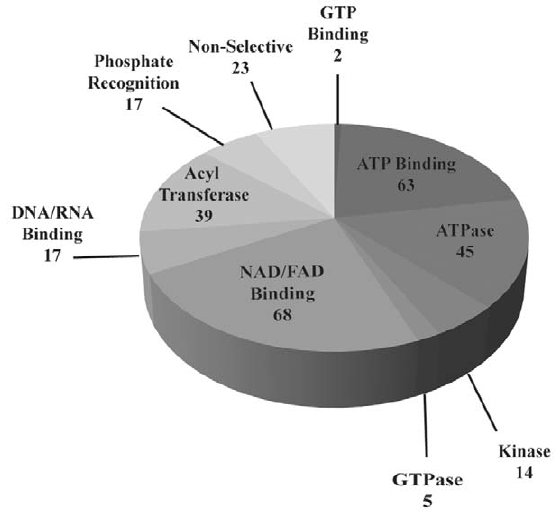
Figure 3. ATP-ABP labeling profile of skeletal muscle mito- chondrial lysates from HFD and SD fed mice. 293 total high confidence unique proteins were identified in total.